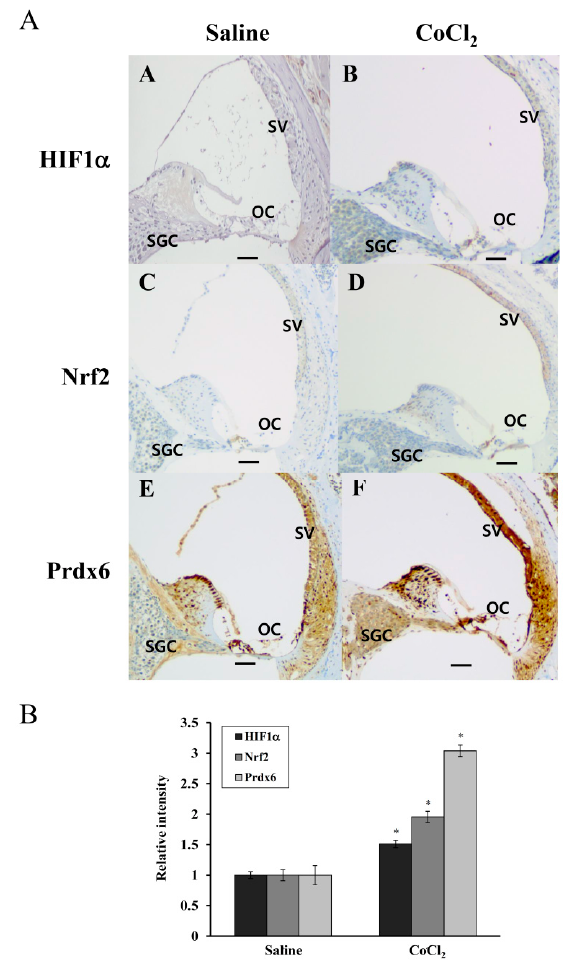
Figure 7. HIF-1 α , Nrf-2, and Prdx6 expression in the cochleae of saline- or CoCl 2 -injected mice. Mouse cochlear paraffin sections were used for immunohistochemical analyses of HIF-1 α , Nrf-2, and Prdx6 expression. ( A ) The expressions of HIF-1 α (A: saline-injected, B: CoCl 2 -injected), Nrf-2 (C: saline-injected, D: CoCl 2 -injected), and Prdx6 (E: saline-injected, F: CoCl 2 -injected) are marked with brown-colored deposits and nuclei are counterstained with hematoxylin. OC, organ of Corti, SV, stria vascularis; SGC, spiral ganglion cells. Original magnification ×100, scale bar = 100 μ m. ( B ) The intensities of the dark brown dots in images were quantified using an Image J program. Data in the graph is presented as fold changes relative to the saline-injected cochleae, expressed as ± SDs of three independent experiments. * p < 0.05, compared with the saline-injected cochleae.